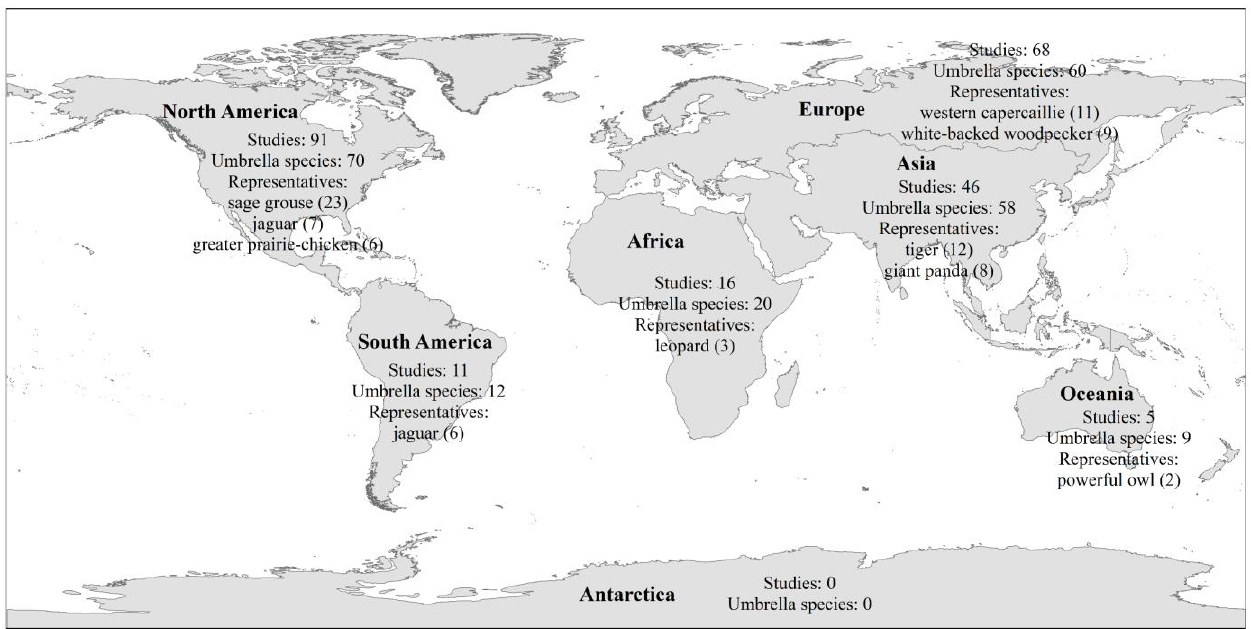
Figure 2. Distribution of study efforts and recommended umbrella species across continents, and the most studied representatives for each continent, with the number of articles on each representative in parentheses.